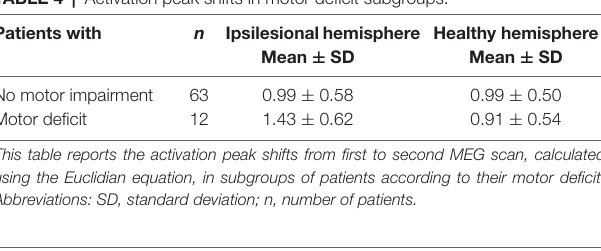
TABLE 5 | Ipsilesional activation peak shifts from first to third scan in tumor location